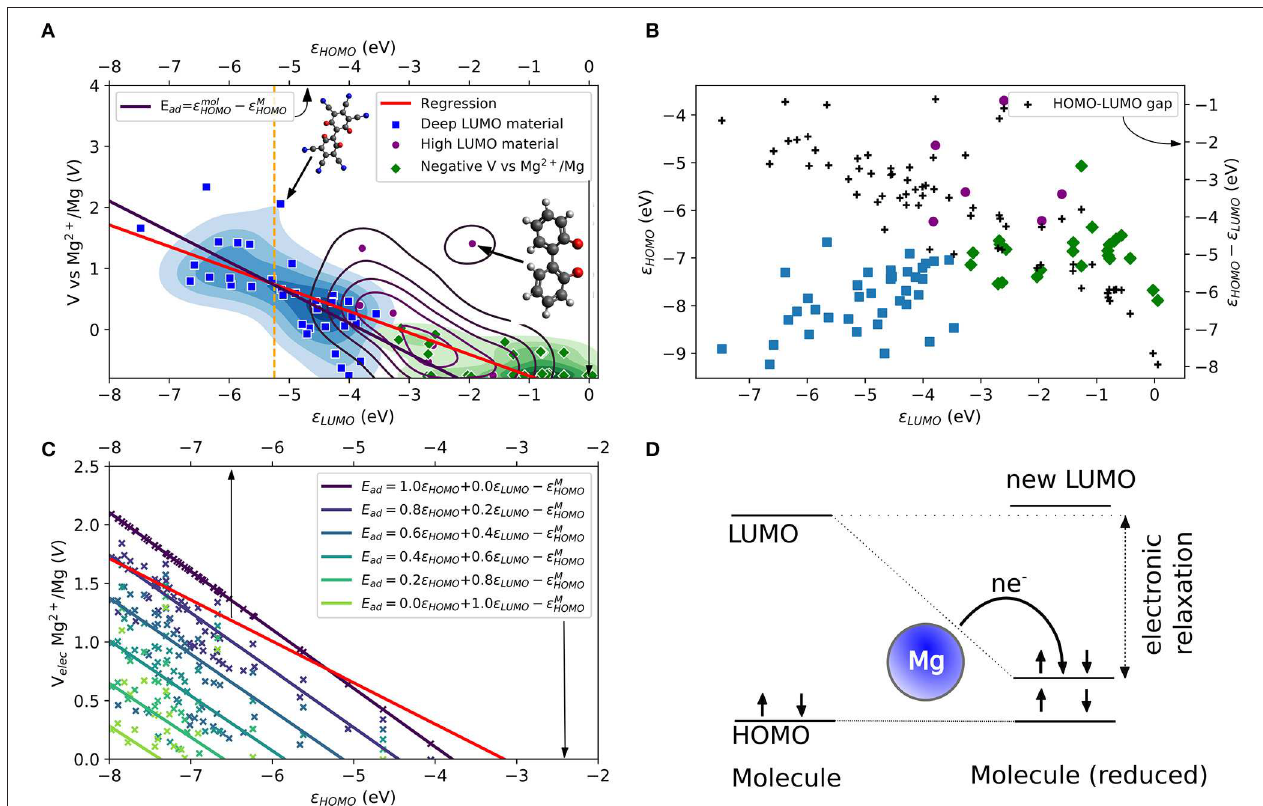
FIGURE 1 | (A) Computed LUMO eigenvalues and theoretical voltages vs. Mg 2 + /Mg for a set of small organic molecules. The molecules are categorized into three groups (blue, purple and green areas and data points) by a k-means algorithm. A linear regression (red curve) is compared to an electronic approximation (black curve) to Equation (2). The top axis refers to a comparison based on the electronic effects assuming a LUMO relaxation reaching HOMO values. (B) Comparison of the relation between HOMO and LUMO eigenvalues, and HOMO-LUMO gaps for the three categories in the dataset. (C) Comparison of the linear regression (red curve) from (a) different LUMO relaxation values in the electronic approximation to Equation (2). (D) Schematic of the LUMO relaxation process during the redox reaction. For a Mg atom, two electrons are transferred (i.e., n = 2). Arrows indicate electrons with spin-up and spin-down. Color code is H (white), C (gray), N, (blue), O (red), F (light blue), Mg (yellow), and S (dark yellow) here and